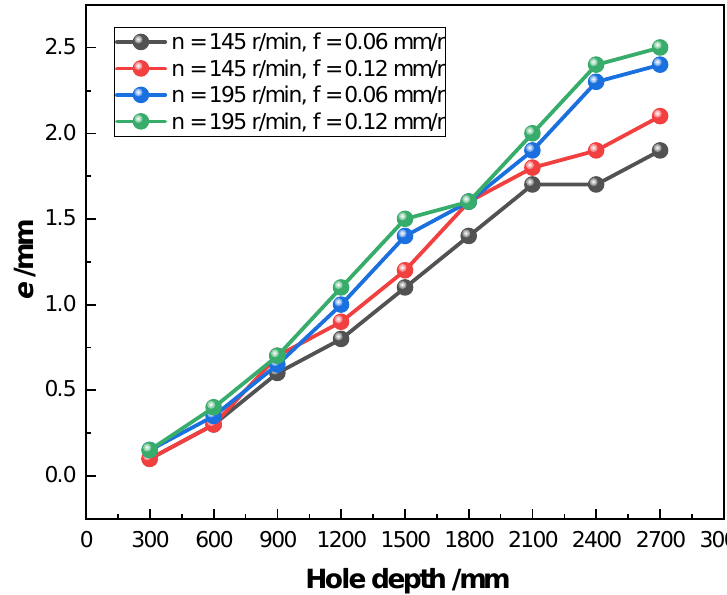
Figure 9. Hole-axis